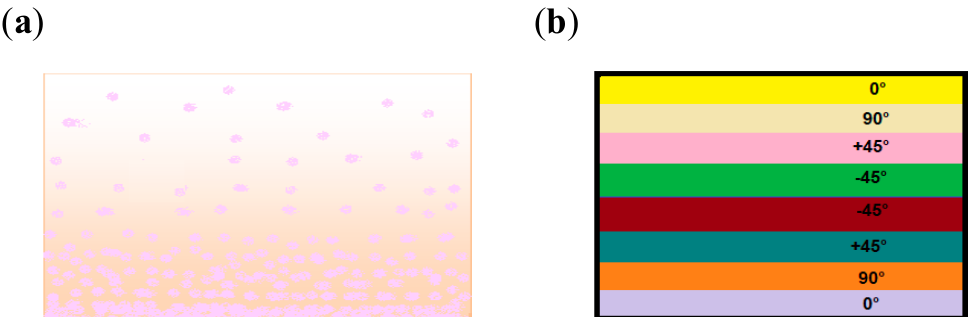
Figure 7. Comparison between ( a ) functionally graded material with smooth graded variations and ( b ) composite laminates with sharp interfaces.